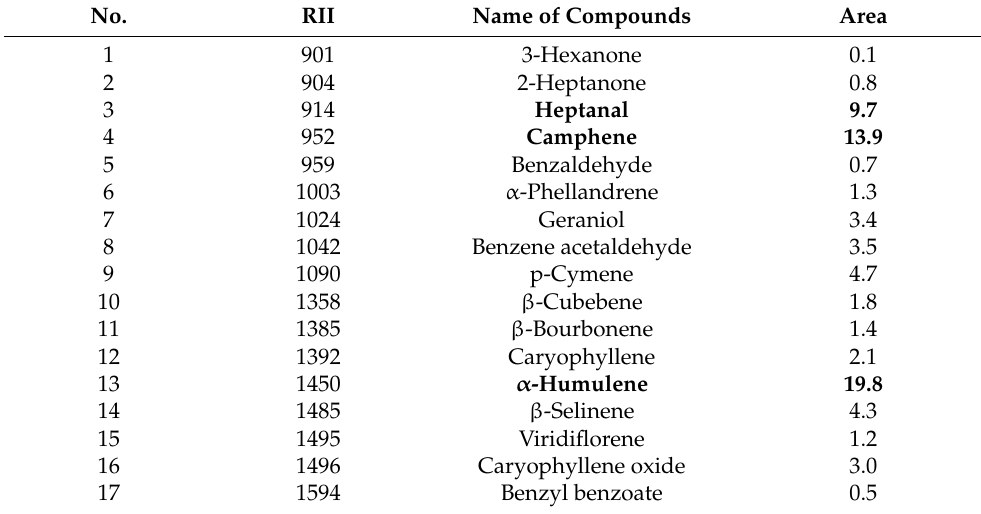
Table 1. Constituents of the essential oil from Aethionema sancakense